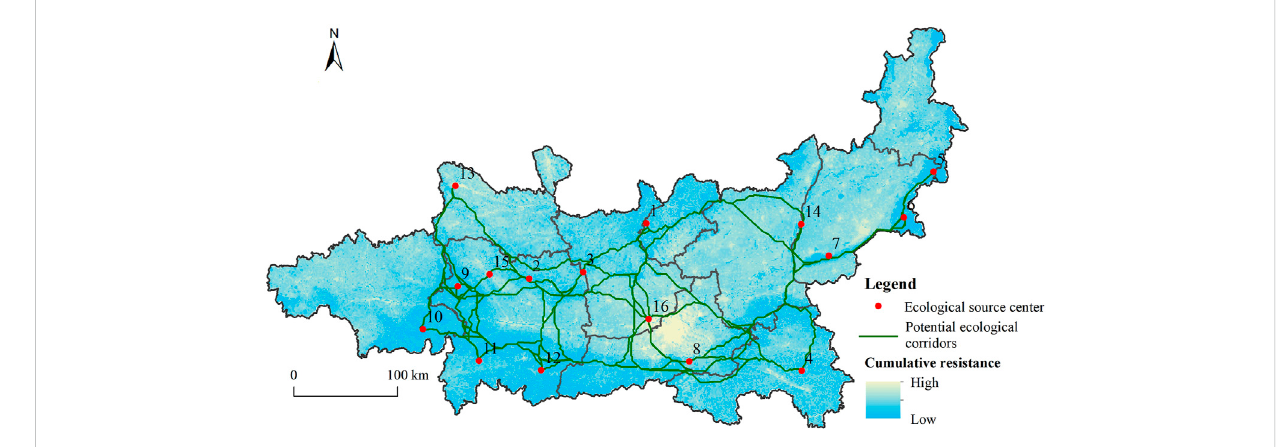
FIGURE 9 Spatial distribution of potential ecological corridors.